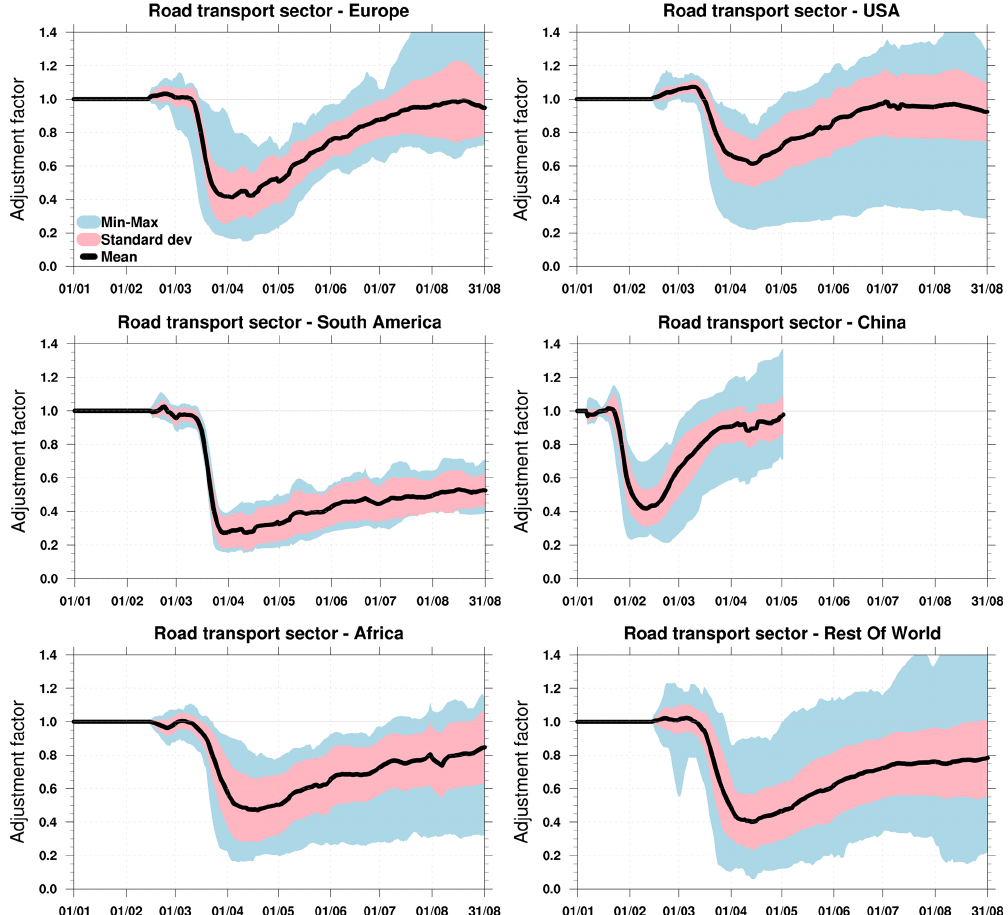
Figure 2. Daily AFs for the road transportation sector from January to August 2020 over Europe, USA, South America, China, Africa and the rest of the world. These estimations are derived from Google’s transit category. The standard deviation values (light pink) result from the AFs for the individual countries or states/provinces. The light-blue color indicates the range of the minimum and maximum